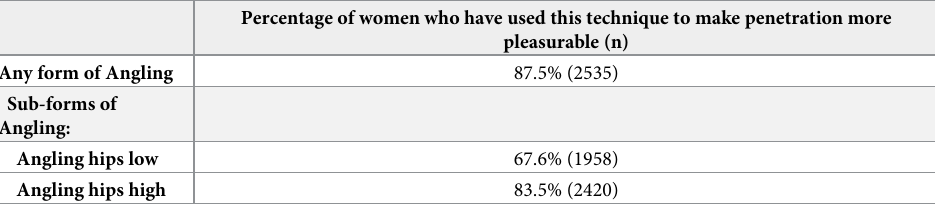
Table 2. Prevalence of use of Angling techniques by women to make vaginal penetration more pleasurable (N = 2898,